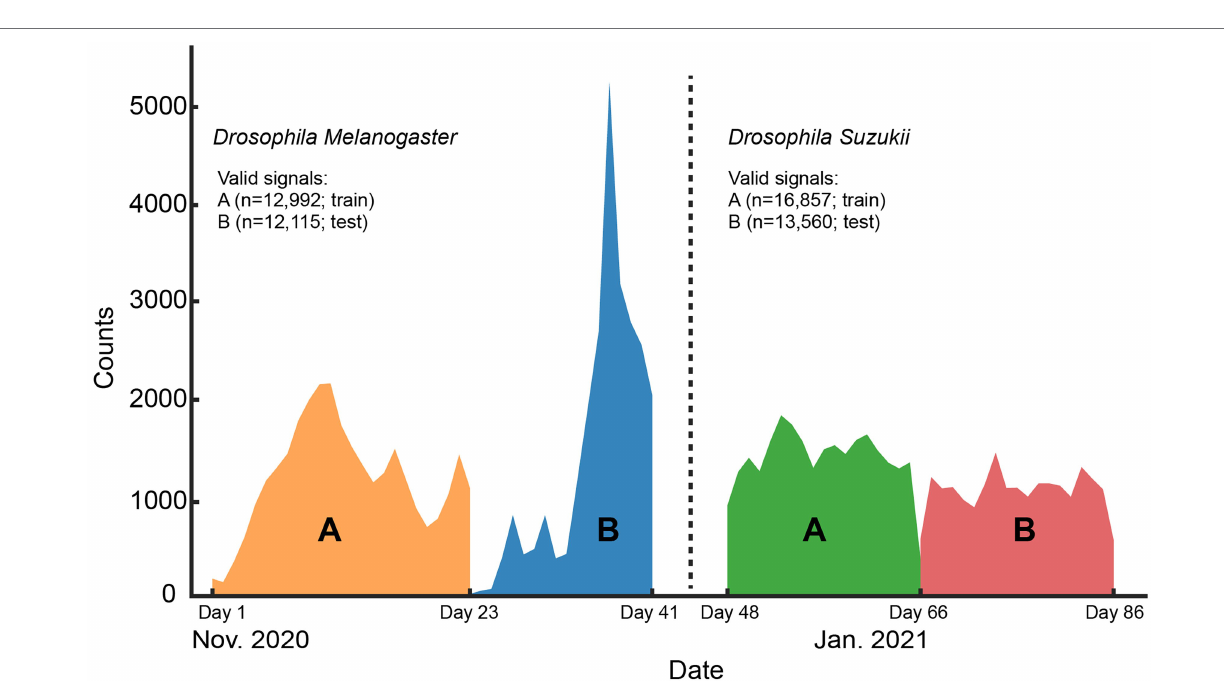
FIGURE 2 | Histogram of the signal counts collected on each day for the whole length of the controlled environment experiment. The number of valid signals per Drosophila species and the data split (train or test) they belong to are shown in the